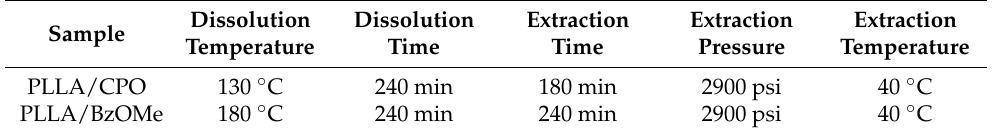
Table 2. Settings for gels and aerogels